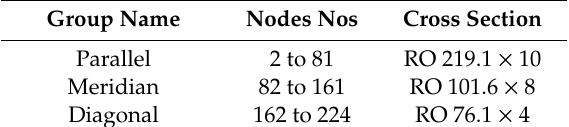
Table 9. Cross sections taken for di ff erent groups of rods.